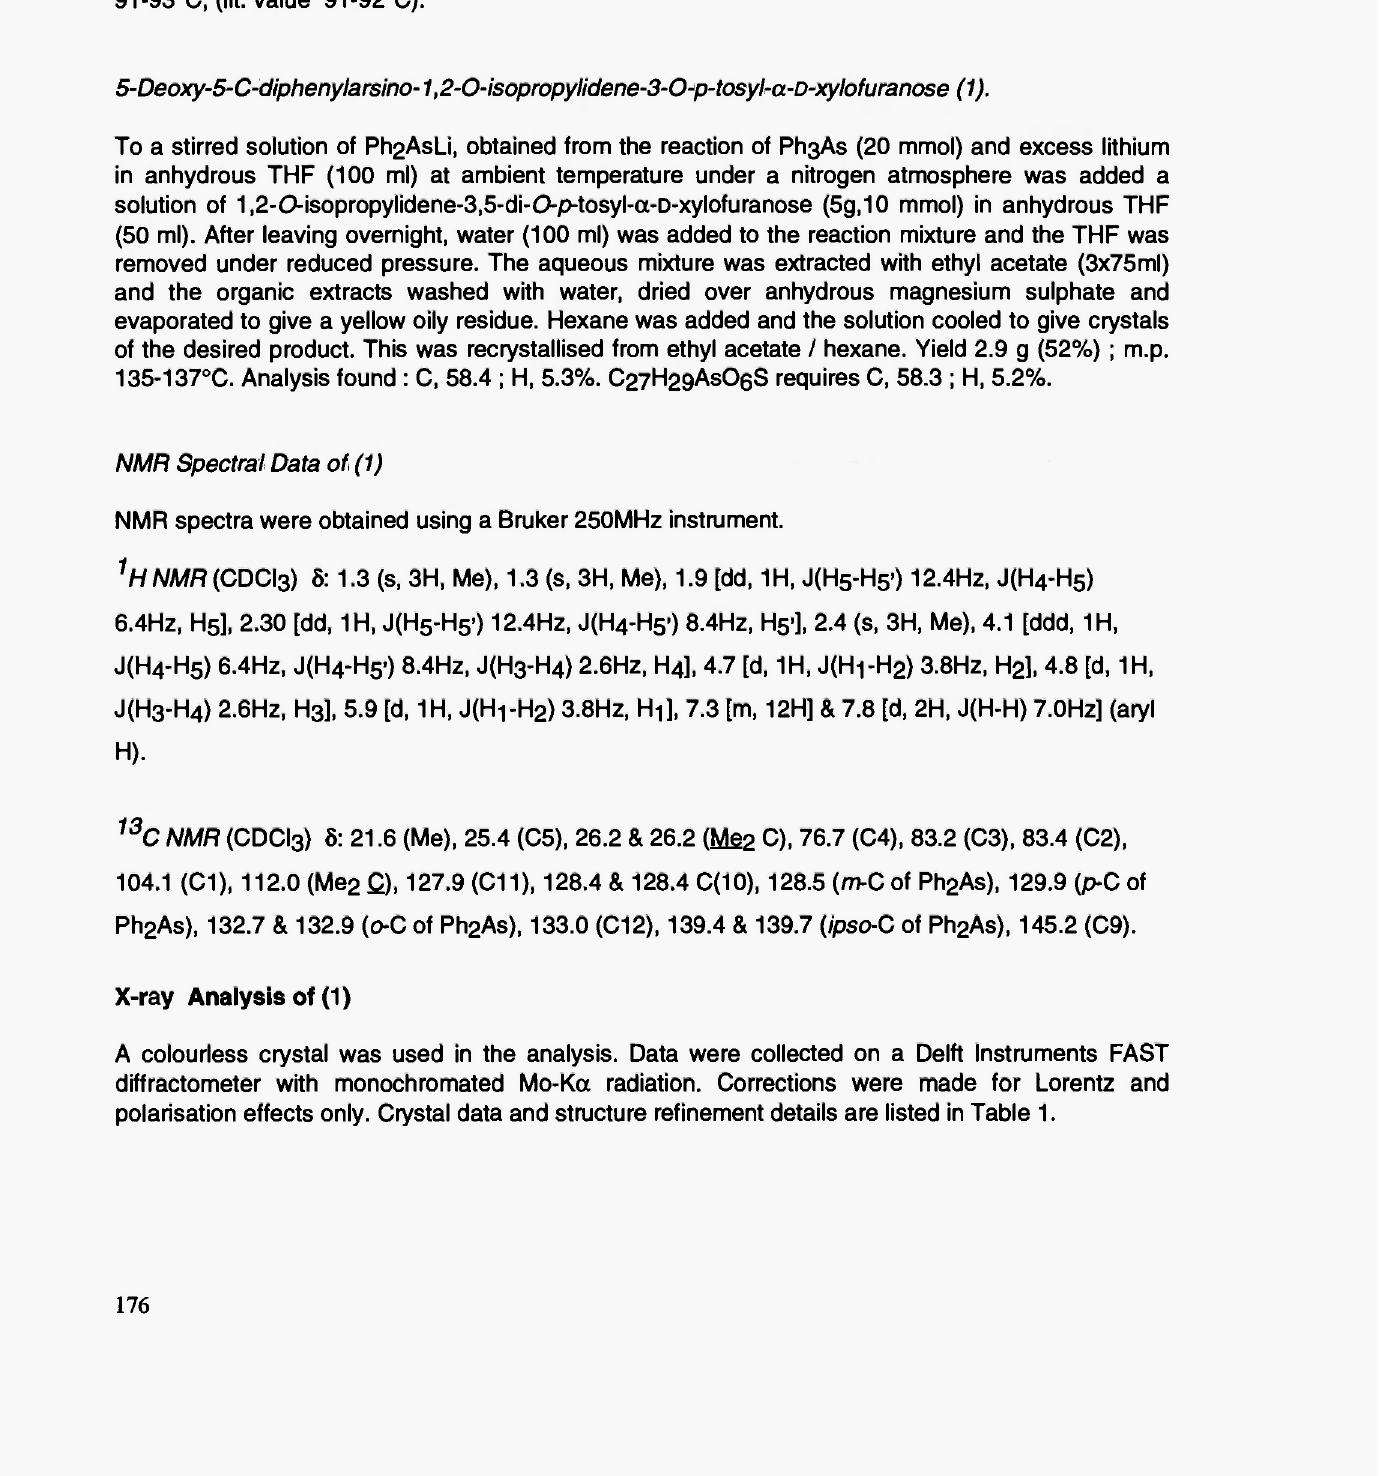
A colourless crystal was used in the analysis. Data were collected on a Delft Instruments FAST diffractometer with monochromated Mo-Κα radiation. Corrections were made for Lorentz and polarisation effects only. Crystal data and structure refinement details are listed in Table